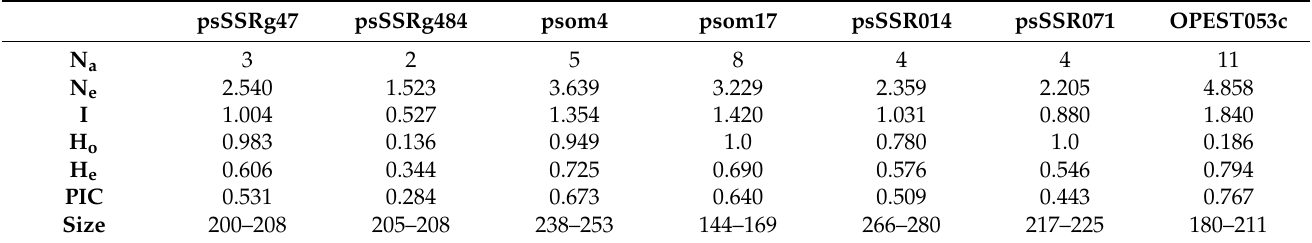
Table 3. The number of the amplified alleles and genetic indices at the studied SSR loci.